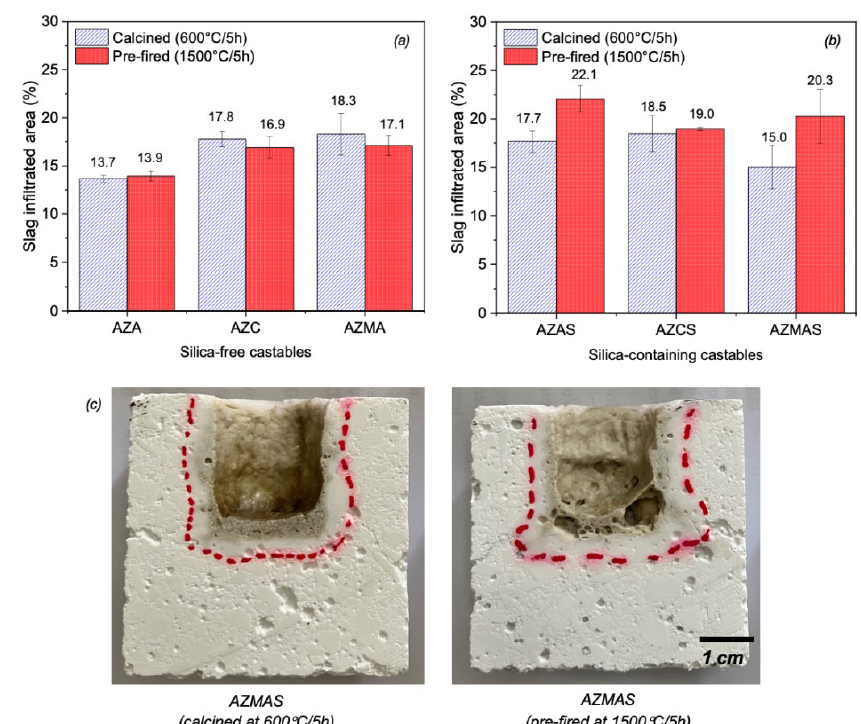
Figure 5. Slag infiltrated area when evaluating (a) silica-free (adapted from Pinto et al. 16 ) or (b) silica-containing (1 wt.%) castables. The samples were calcined at 600 °C for 5h or fired at 1500 °C for 5 h before testing. The corrosion cup experiments were carried out at 1500 °C for 2 h. (c) Photographs of the calcined and pre-fired AZMAS samples after the corrosion tests. The red dashed lines point out the extent of the slag infiltration into the castables’